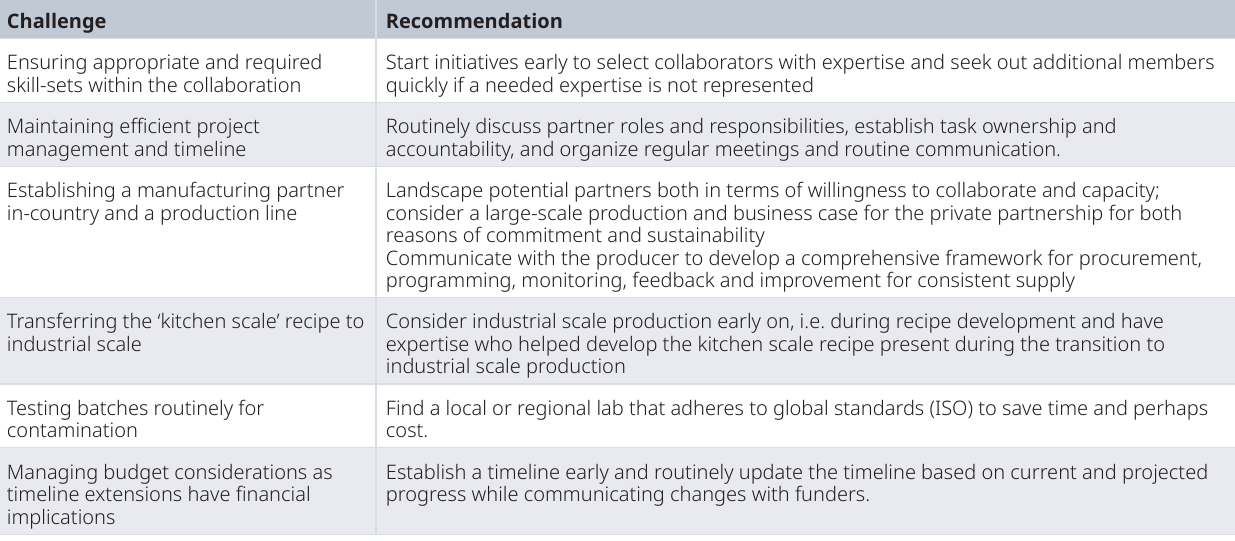
Table 1. Key challenges and recommendations. Challenge